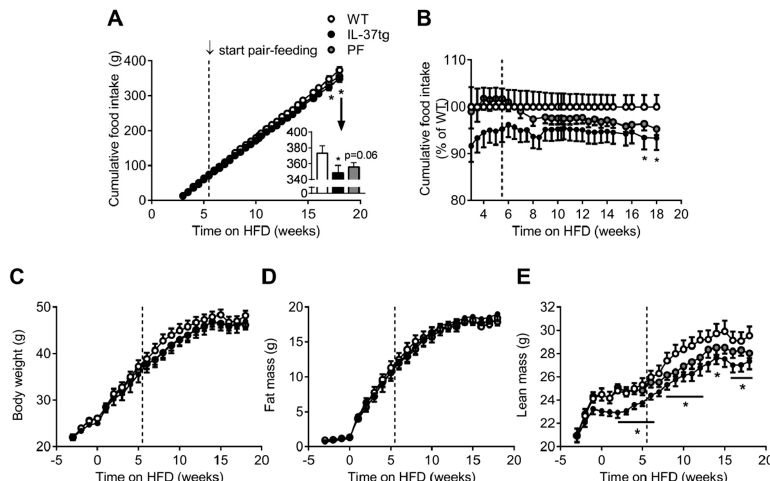
Figure 2. Reduced food intake in heterozygous IL-37tg mice decreases lean body mass. 10-week old male C57Bl/6J mice and heterozygous IL-37tg mice on a C57Bl/6J background were fed a high-fat diet (HFD) for 18 weeks. Pair-feeding of wild-type (WT) mice (PF group) was initiated after 5.5 weeks of HFD feeding and is indicated by the dotted line ( A – D ). Food intake (FI; A , B ), body weight ( C ), fat mass ( D ) and lean mass ( E ) were measured at indicated time points. Values represent means ± SEM ( n = 10 animals per group). * p < 0.05 IL-37tg vs. wild-type